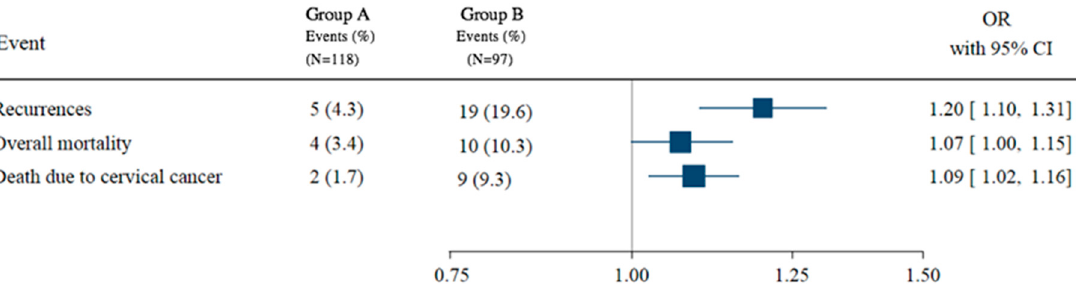
Figure 1. Oncological outcomes after balancing group A and group B with the IPTW. The odds of recurrence, overall mortality, and disease-specific mortality after balancing the sample for age, BMI, histology, size, grade, lymphovascular invasion, adjuvant treatment, and nodal status. ORs for all events were higher and statistically significant for group B compared to group A (OR Recurrence = 1.23, 95% CI = 1.13–1.15, p -value = 0.001; OR Death = 1.10, 95% CI = 1.02–1.18, p -value = 0.012; OR Death-cervical- cancer = 1.11, 95% CI = 1.04–1.19, p -value = 0.002). Table 3. ESGO quality indicators related to the treatment of cervical